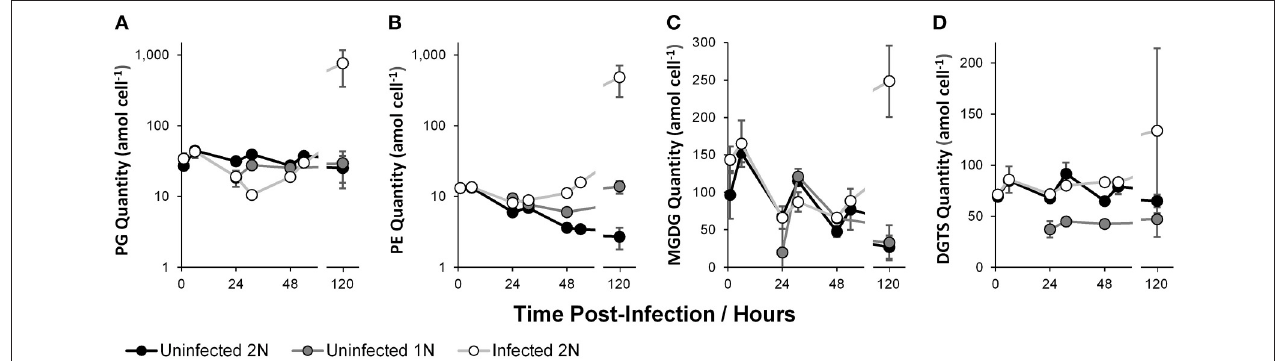
FIGURE 2 | Polar glycerolipid quantity per E. huxleyi cell: Phosphatidylglycerol (PG, A); Phosphatidylethanolamine (PE, B); Monogalactosyldiacylglycerol (MGDG, C); and Diacylglyceryltrimethylhomoserine (DGTS, D). Data represent the mean average of two biological replicates with error bars of one standard deviation. See Supplementary Table 1 for tabulated data.